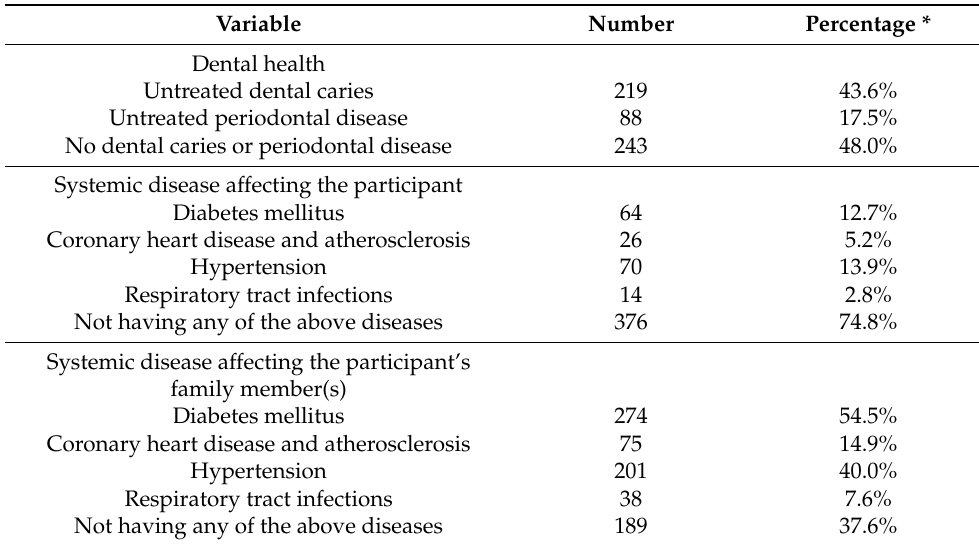
Table 2. Dental and systemic health conditions affecting the study